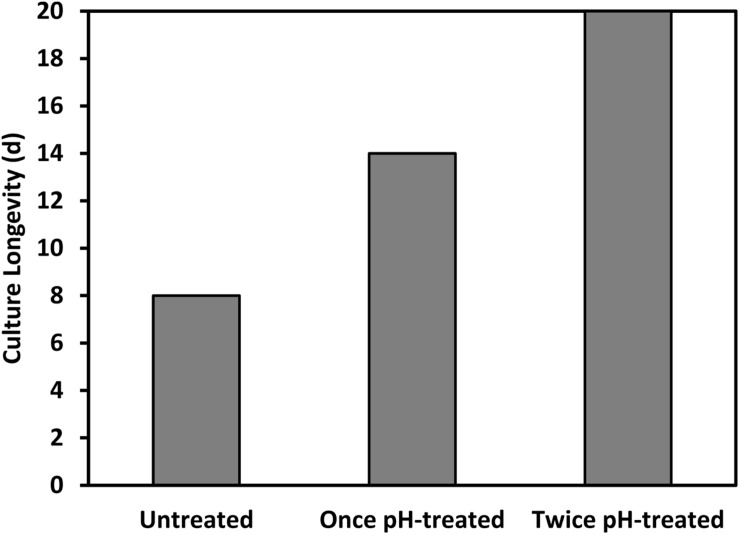
Longevity of a Chlorella culture was prolonged by applying the pH treatment repeatedly to the same culture upon transfer, at the beginning of at least two consecutive batch cycles.